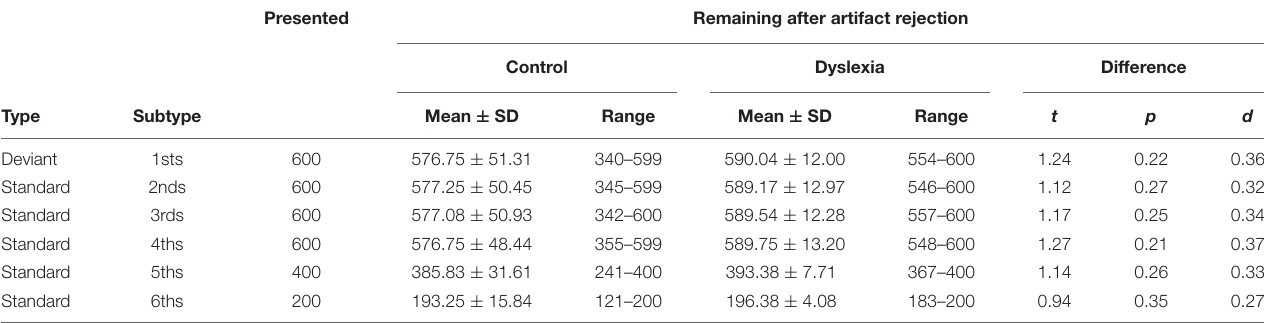
FIGURE 3 | Decoding deviant vs. standard as a function of repetition history and number of trials. (A) Time courses of decoding accuracy as a function of the level of repetition of the standard. In each subplot, classifiers were trained to distinguish deviant trials from standard trials, where standards were, from left to right, the 2nd, 3rd, 4th, 5th, or 6th tokens in their train. Within-participant decoding results are shown as group averages (Control, blue; Dyslexia, red). Time points of significantly above-chance decoding are indicated by horizontal lines in corresponding colors below the traces (one-sample sign-permutation tests with cluster-based correction). No significant differences between groups in accuracy were identified (two-sample sign-permutation tests with cluster-based correction). (B) As in (A) , but in order to investigate the effect of trial numbers on decoding accuracy, we took a random subset of each participant’s 2nd, 3rd, 4th, and 5th standard trials equal to their number of usable “6th” before repeating the decoding analysis. This procedure significantly reduced decoding accuracy in every case [sign-permutation tests on differences from (A) to (B) ]. TABLE 2 | Number of usable trials by type and